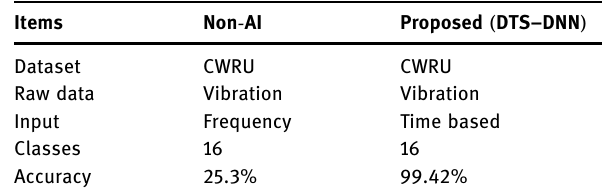
Table 5: Comparison of accuracy with non - AI technique